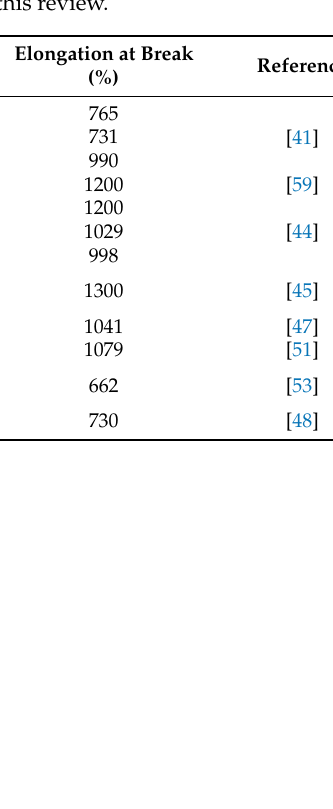
Table 5. Mechanical properties of degradable TPEs described in this review.